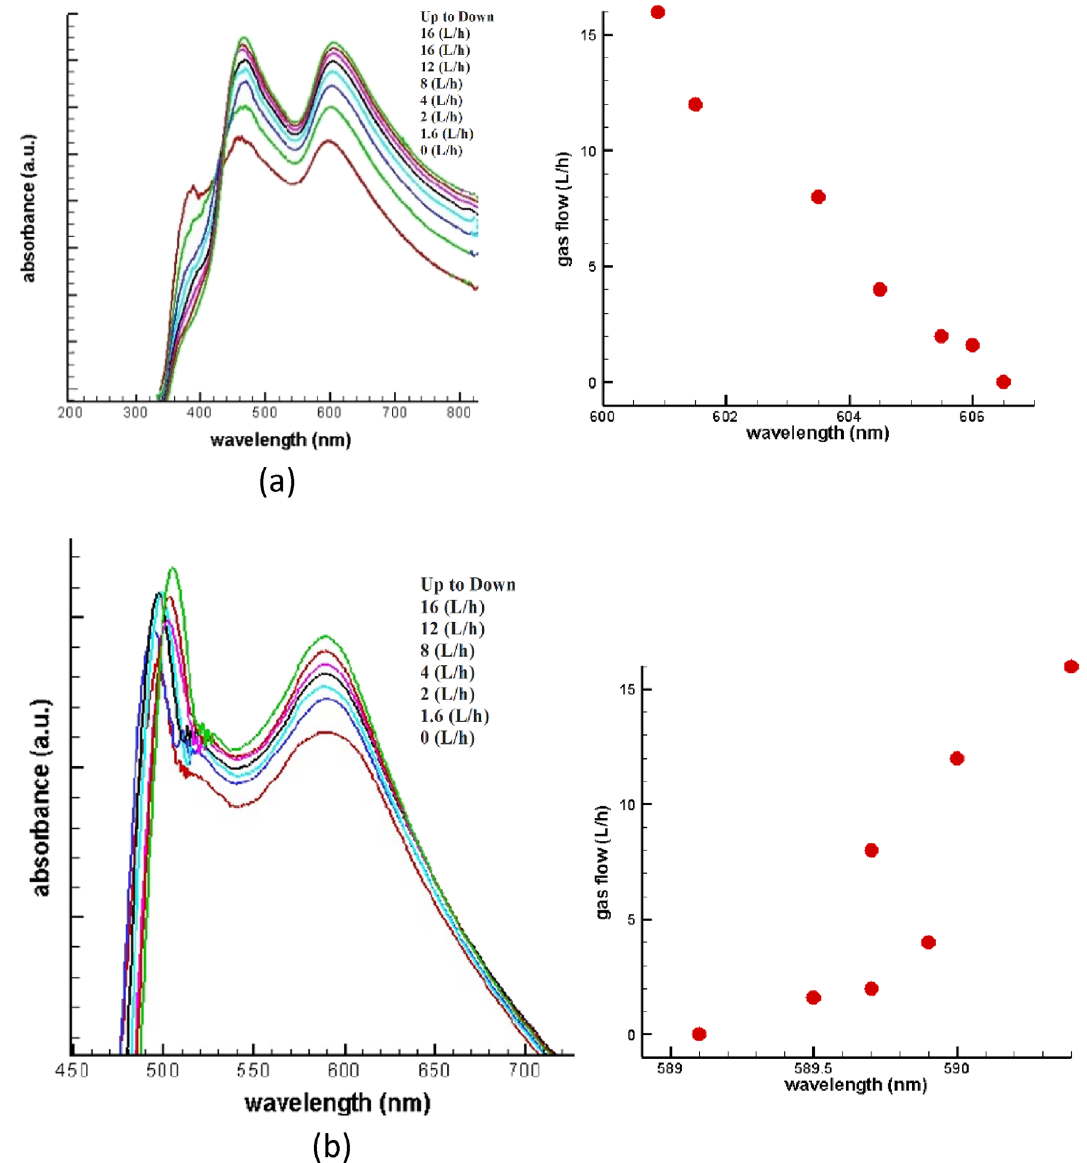
Figure 5. Absorption spectra of NPs under air and CO flow, position of plasmonic peak versus gas flow for a) CuNi15 and b)